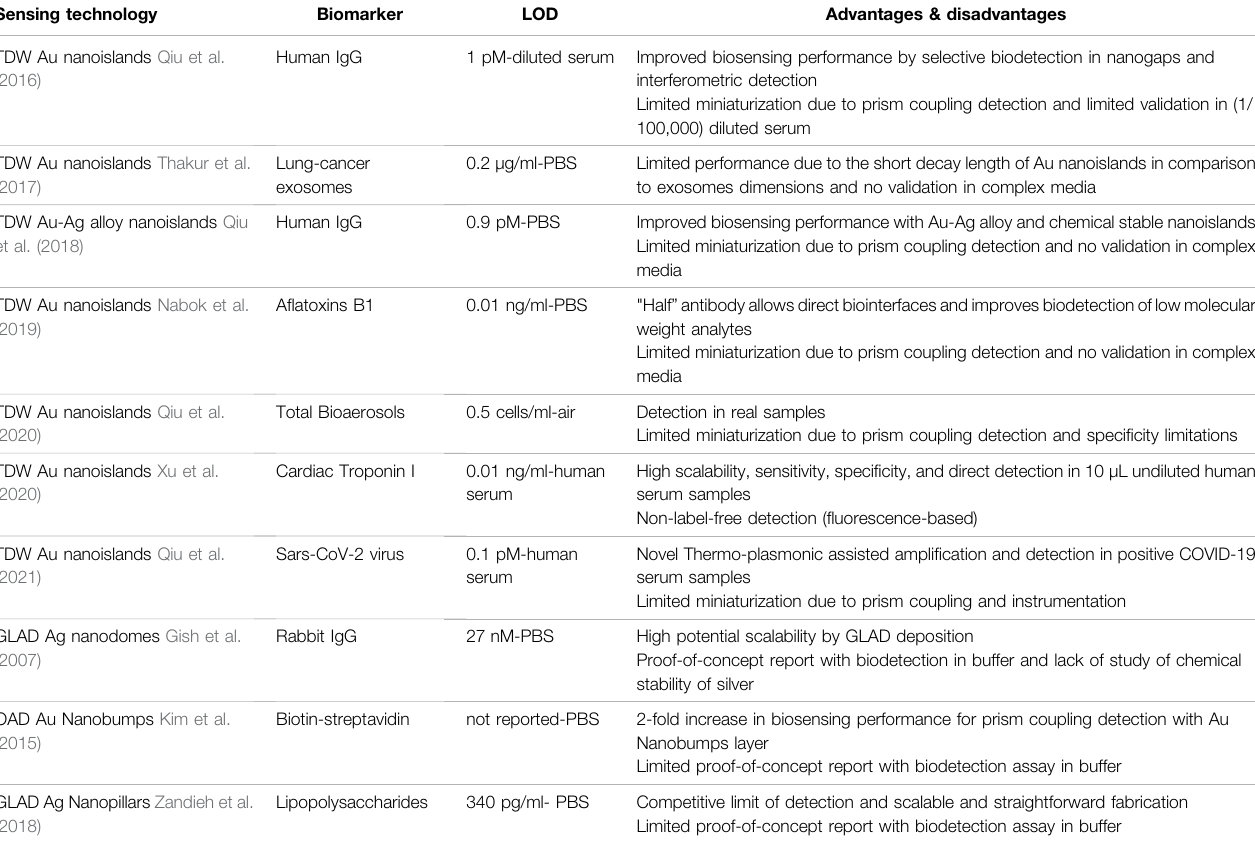
TABLE 1 | Research papers overview using GLAD and TDW plasmonic metasurfaces for biosensing. Sensing